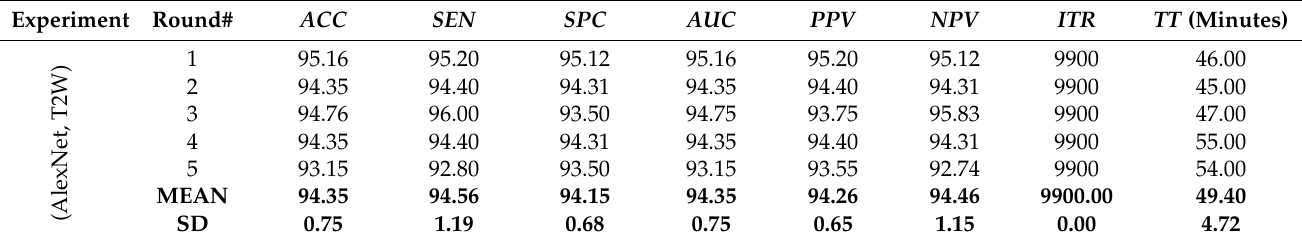
Table A9. Test results of five-folds of the experiment (AlexNet,